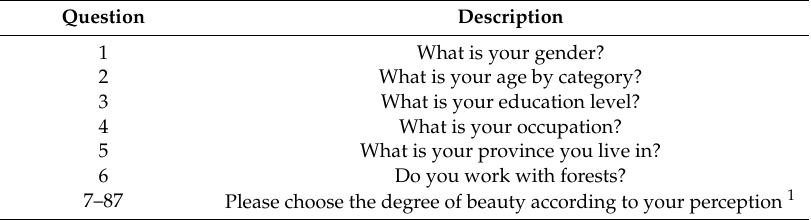
Table 1. Content of questionnaire statements for respondents to answer.